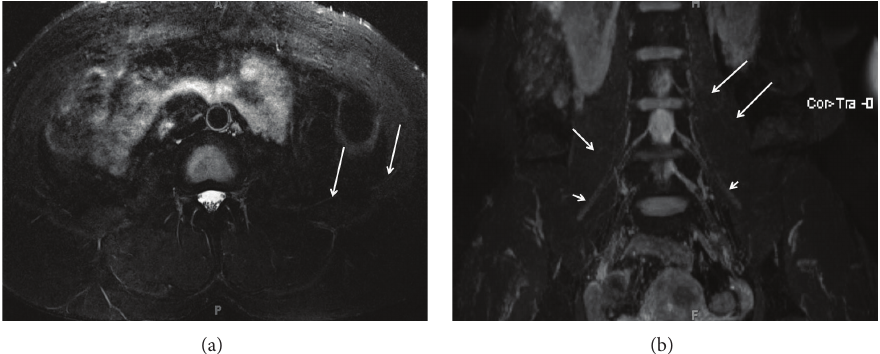
Figure 2: (a) 2D versus 3D anatomic nonselective MRN-Axial T2 SPAIR image through the lower abdomen shows the abnormally hyperintense left ilioinguinal nerve (arrows) in a suspected case of left ilioinguinal neuropathy. (b) 2D versus 3D anatomic nonselective MRN-MIP reconstruction from a coronal 3D STIR SPACE sequence barely shows the left ilioinguinal nerve (large arrows). Notice normal right ilioinguinal nerve (medium arrow) and normal bilateral femoral nerves (small